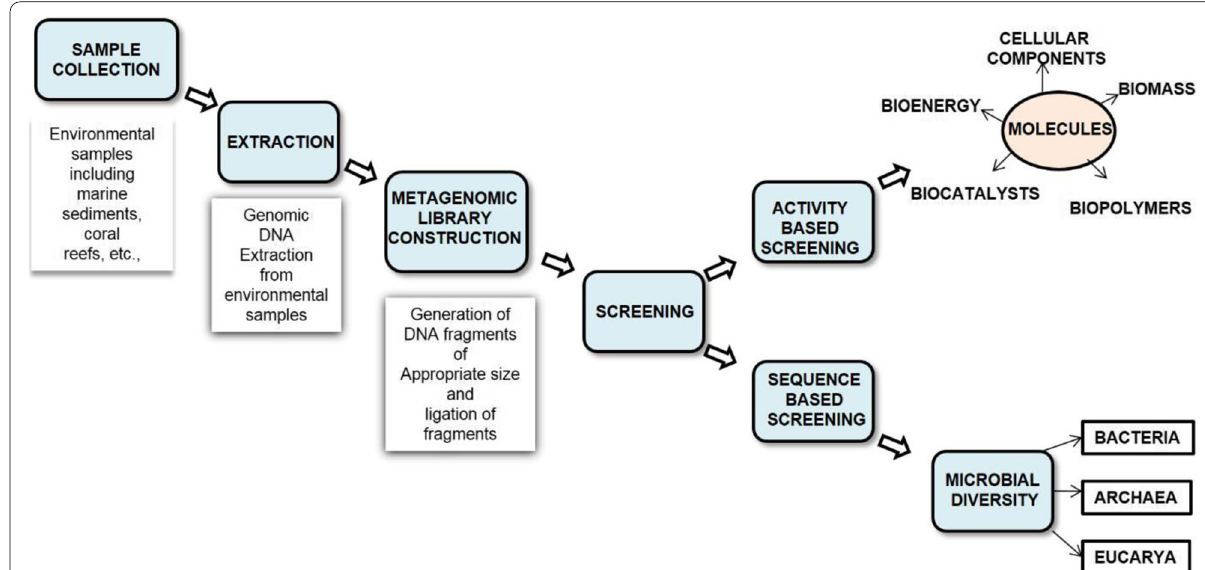
Fig. 1 Sample collection and processing by a metagenomic approach (Marine environmental samples are collected from different marine sources, and the genomic DNA is extracted from the samples. The metagenomics library construction helps in the generation of DNA fragments of appropriate size and also in the ligation of the fragments followed by screening)